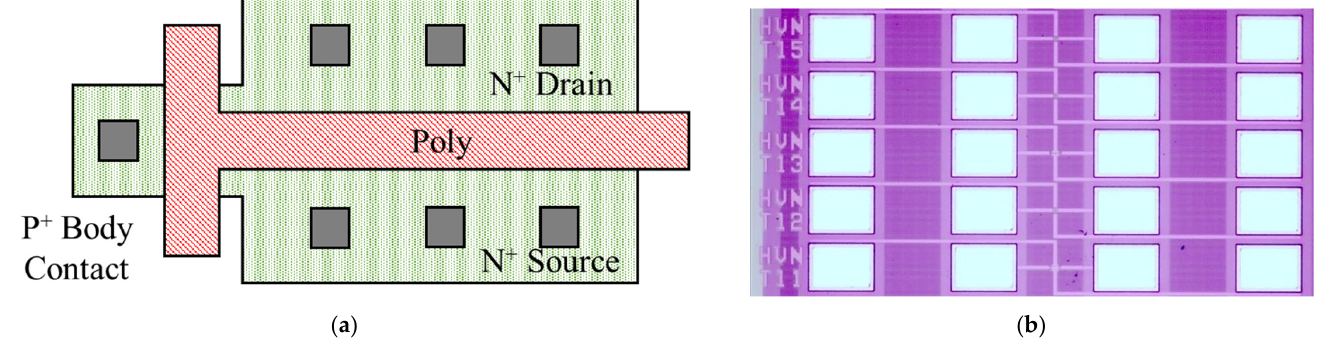
Figure 1. Layout of T-gate transistor used in our study and microscopic image: ( a ) T-gate transistor layout (the T-gate is used for body contact to suppress the floating-body effect); ( b ) microscopic image of the devices. The pads in the diagram are, from left to right, the gate, drain, source, and body.